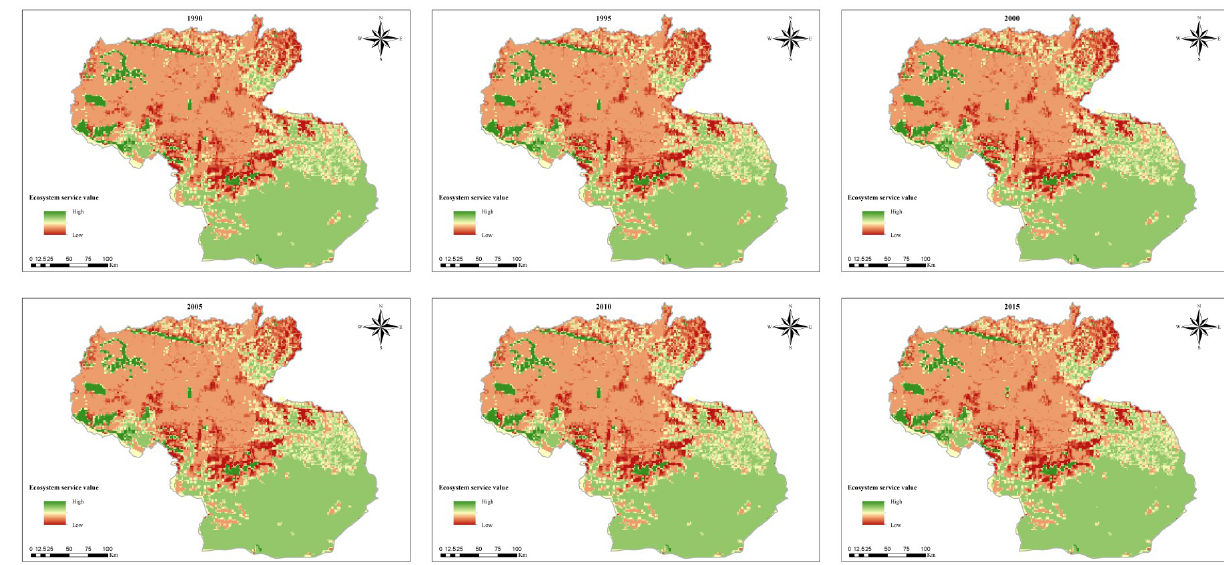
Figure 4. Spatial pattern of ecosystem service value in Shannan. Table 2. Change in ESV in Shannan based on TG from 1990 to 2015 (CNY/hm 2